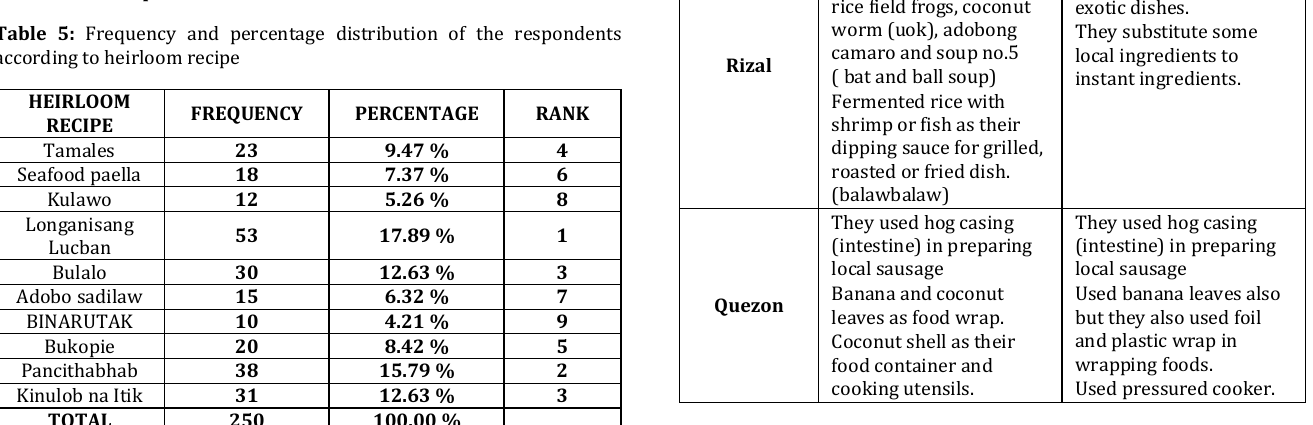
Frequency and percentage distribution of the respondents according to heirloom recipe HEIRLOOM